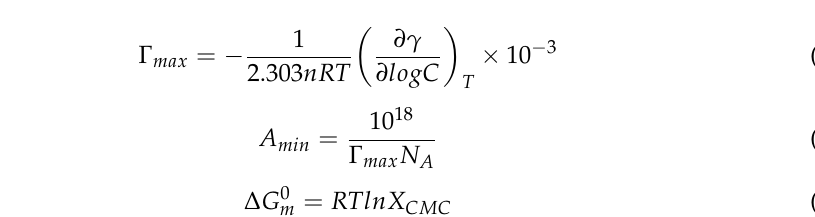
Figure 5. Separation results of mixed minerals under the action of the NaOl (pH = 10, dosage = 0.1 mM) or NaOl/TDM (pH = 9, dosage = 0.1 mM, NaOl:TDM mole ratio = 8:2) collector at 283 K.